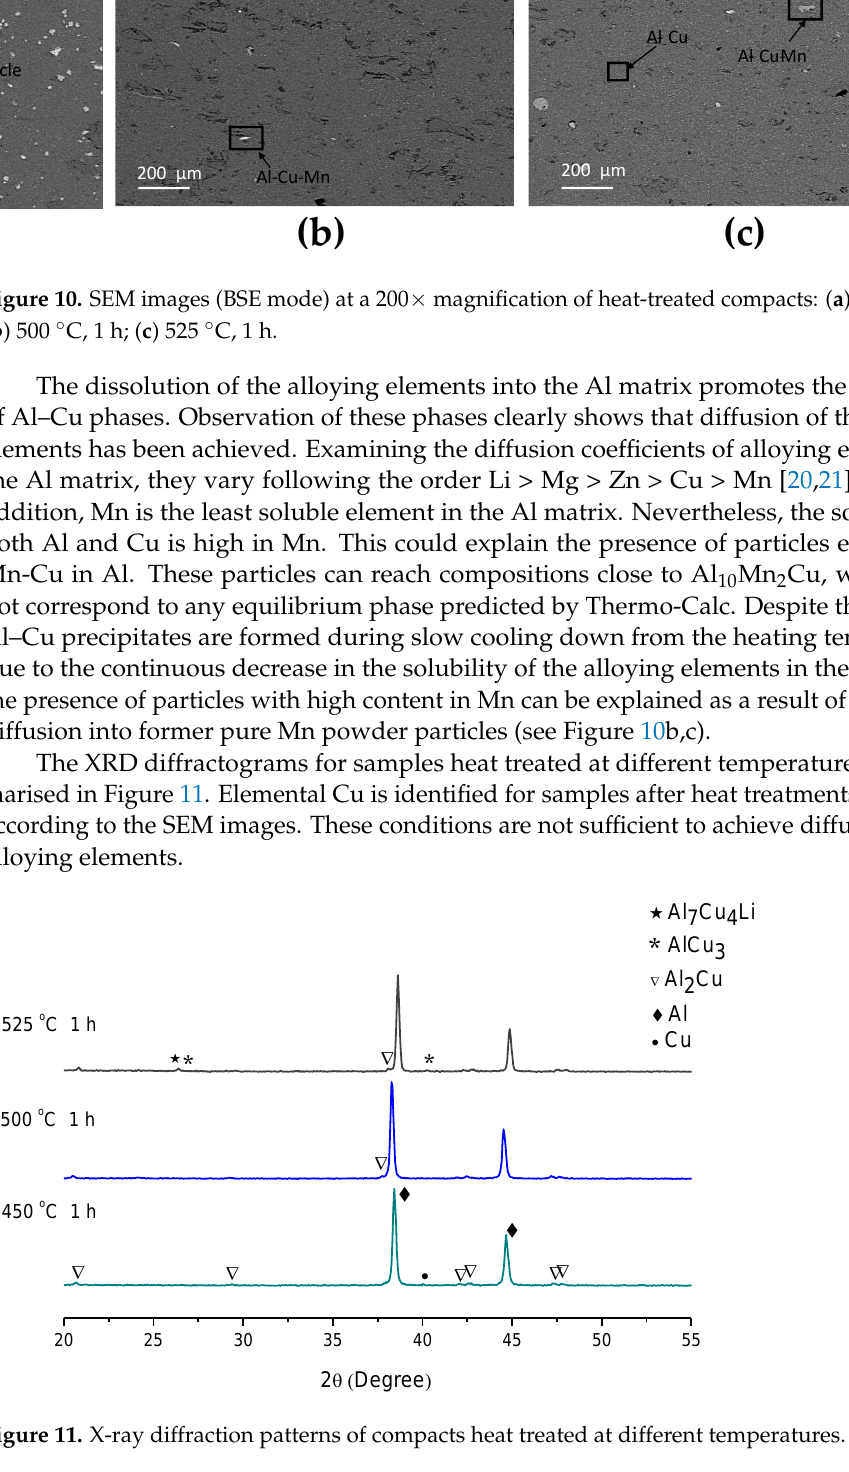
Figure 10. SEM images (BSE mode) at a 200× magnification of heat-treated compacts: ( a ) 450 °C, 1 h; ( b ) 500 °C, 1 h; ( c ) 525 °C, 1 h.